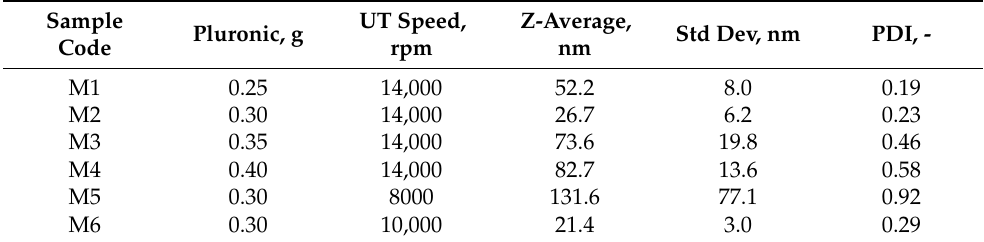
Table 2. Z-average and PDI evaluated by DLS on miniemulsion droplets prepared with increasing amounts of Pluronic PE 6100 in the continuous phase and increasing homogenization speed.